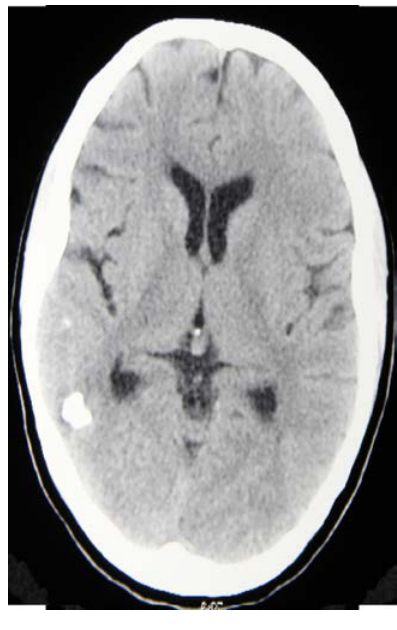
Figure 2. Axial computed tomography brain imaging showed areas of right pari- etal lobe hyperdensities consistent with calcification and mild cerebral atrophy of the right cerebral hemisphere as evidenced by prominence of the cerebral and Sylvian fissures.Figure 1. A) Showing right facial hemiatrophy and en coupe de sabre ; B) showing bald